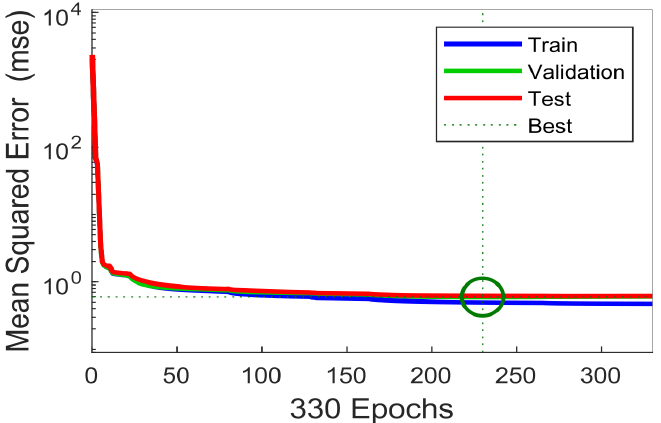
Figure 8. RMSE evolution during training epochs of the temperature estimation of the Samsung